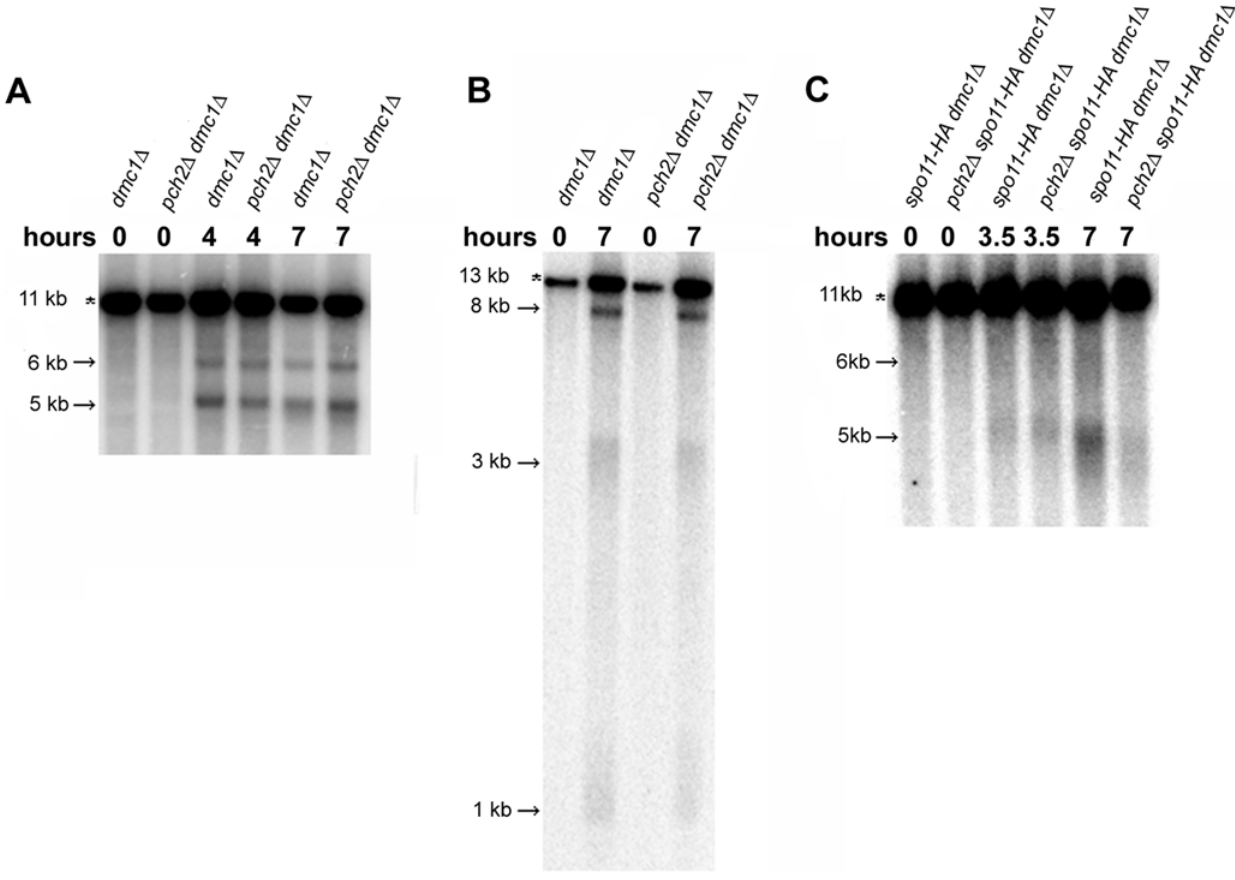
Figure 5. pch2 does not appear to have increased levels of meiotic DSBs. Southern blots were performed to measure meiotic DSBs in dmc1 D , pch2 D dmc1 D , spo11-HA dmc1 D , and pch2 D spo11-HA dmc1 D strains. For the YCR048w hotspot on chromosome III (A) DNA was digested with Bgl II and probed with a chromosome III fragment (SGD coordinates 215,422-216,703, [63]). For the CEN15 hotspot (B), DNA was digested with Sph I and Nhe I and probed with a chromosome XV fragment (SGD coordinates 331,713-332,402, [42]). The parental bands are marked with asterisks and arrows show bands that form due to DSB formation. Approximate sizes for all bands are shown [42,63]. The lanes on the CEN15 blot have been reordered for easy comparison of the two strains. (C) Analysis of DSBs at the YCR048W hotspot at T=3.5 and 7 hrs in spo11-HA dmc1 D (EAY2562/ EAY2563) and pch2 D spo11-HA dmc1 D (EAY2564/EAY2565) strains. A representative blot is shown. In side-by-side experiments the DSB levels at T=7 hrs in pch2 D spo11-HA dmc1 D ranged from 30-90% (30, 61, 72, 76, 80, 89, and 90%) of the levels observed in spo11-HA dmc1 D